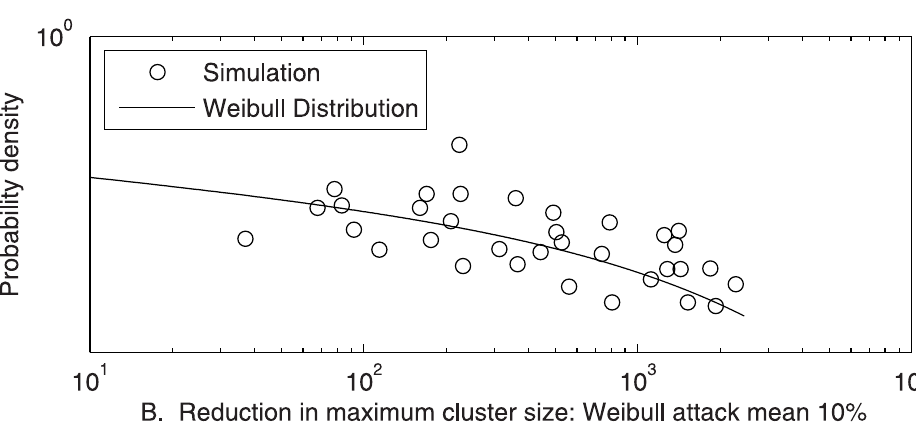
Fig 5. Simulated illness severities, Δ S , defined as reduction in the size of the largest cluster remaining after removal of some of the most connected vertices of 50 1000-vertex scale-free networks, and fitted Weibull distributions. Severities were simulated as (a) Δ S — 162 after removal of 5 vertices, and (b) Δ S after removal of discrete Weibull-distributed numbers of vertices averaging 5. [Conditions: average network connectivity distributed normal (25, 5); MLE parameter fits]